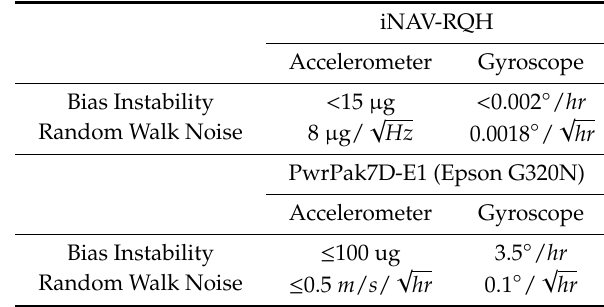
Table 1. Specifications of the iNAV-RQH (reference system) and Epson